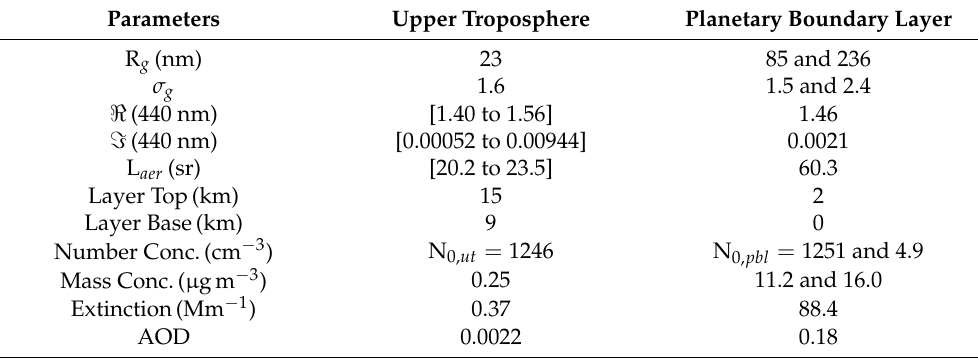
Table 1. Properties of aerosols in the upper troposphere (Aitken mode) and the boundary layer (fine and coarse modes) used as input to the Mie code and lidar signal simulations. Number size distributions are log-normal with median radius R g and geometric standard deviation σ g . Real ( (cid:60) ) and imaginary ( (cid:61) ) refractive indexes were obtained from 8 years of AERONET measurements at the Manaus_Embrapa site. The aerosol lidar ratio L aer is calculated by the Mie code and varies with the refractive index. The altitude range and concentration are based on the median profile shown by Andreae et al. [25], which was approximated by two aerosol layers as shown in Figure 1. Ranges in brackets, corresponding to the 10th and 90th percentiles, are given for the parameters randomized in the Monte Carlo experiments. Number, mass, extinction and AOD of the UT aerosol layer were varied in the sensitivity experiments, from 1 × to 16 × the values shown